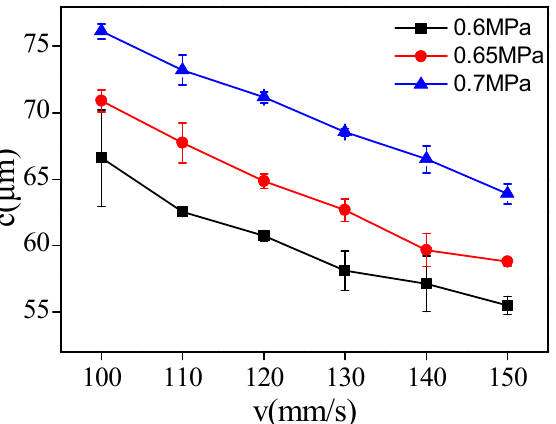
Figure 5. Experimental measurement data for the single-factor analysis.